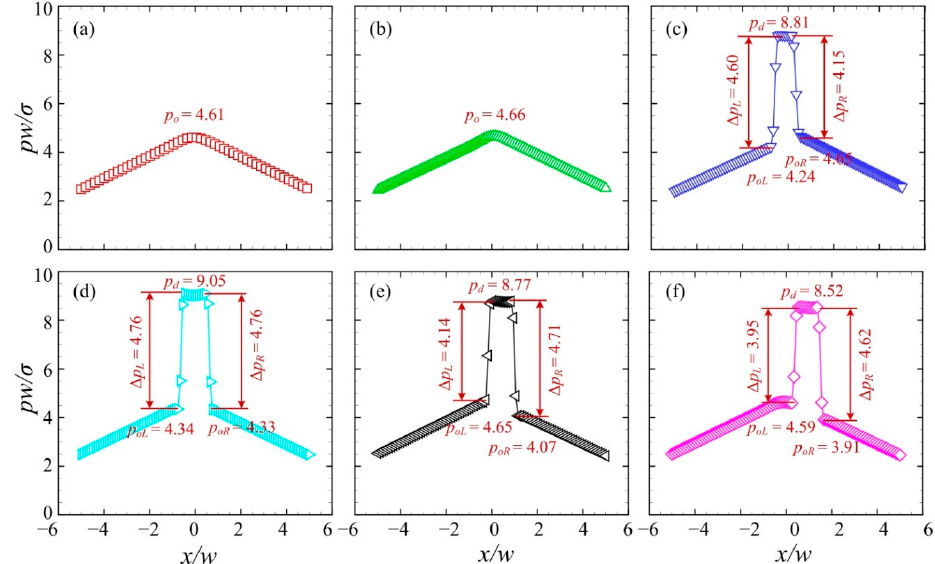
Figure 7. Pressure distributions along the centreline of the branching channels when the droplet is sorted into the right channel at V d /w 3 = 0.6 ( θ = 50°, U = 20 mm/s). ( a ) T0, ( b ) T1, ( c ) T2, ( d ) T3, ( e ) T4, ( f )